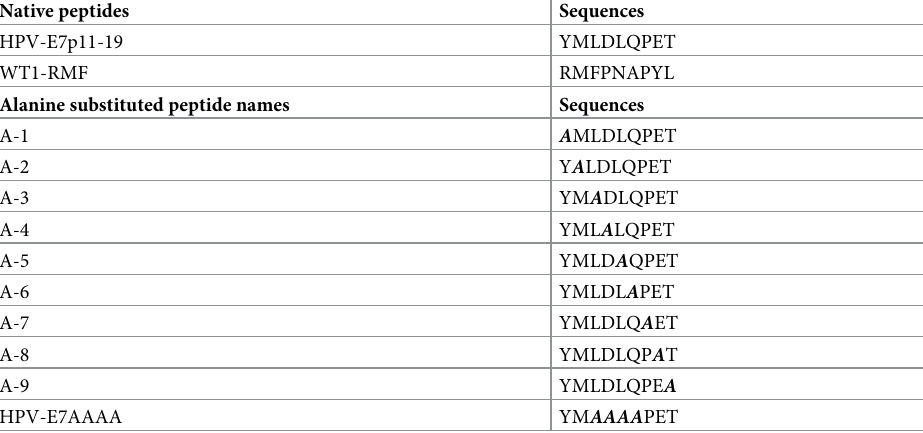
Table 1. Peptides used for the selection and characterization of mAbs specific for HPV-E7p11/HLA-A2 complex. Native